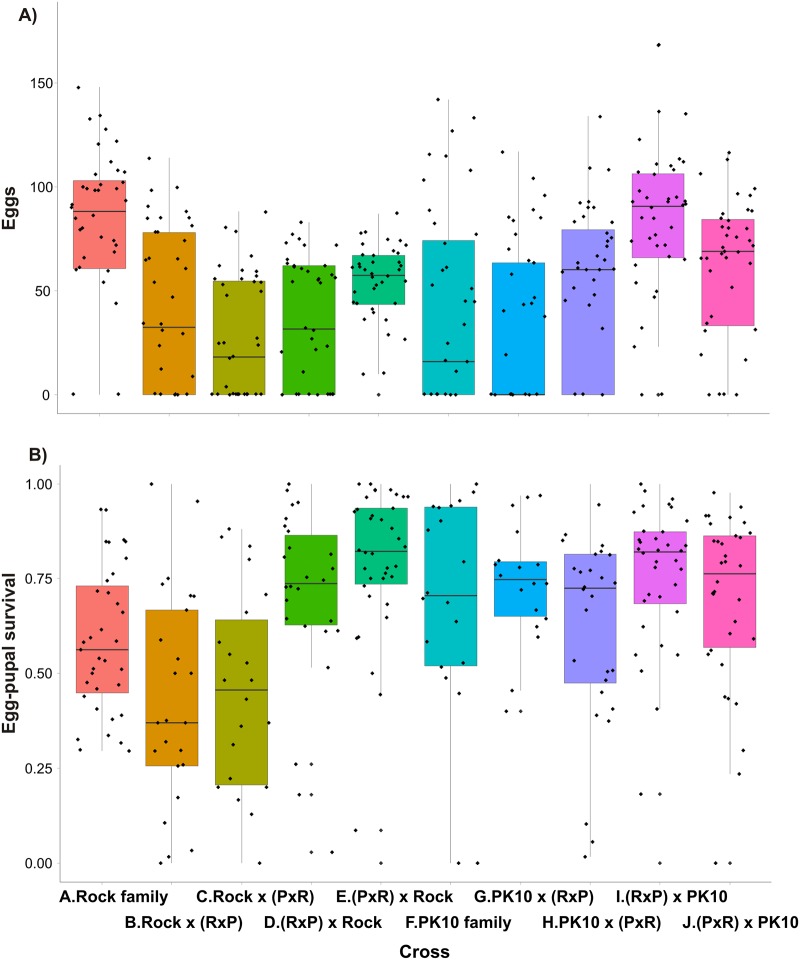
Prezygotic barriers to gene flow within and among D2S3, Bignona (G) and Bignona (F) strains.Pairs of newly emerged virgin adults were placed together in half liter cartons and maintained with sugar water for 10 days. Females were blood fed on days 3 and 5. Following oviposition, spermathecae were inspected at 40X under a compound microscope to check for motile sperm in all three spermathecae. (A) The number of spermathecae (sp) checked per female and indicates that in no case were females uninseminated and on average 77% of spermathecae contained motile sperm. (B) The number of F1 eggs that survived to pupae. The proportion surviving is graphed alongside the Bayesian 95% Highest Density Interval (HDI). Survival rates were uniform among all crosses except for the D2S3 and Bignona(F) intercrosses and the Bignona(G) x Bignona(F) cross.